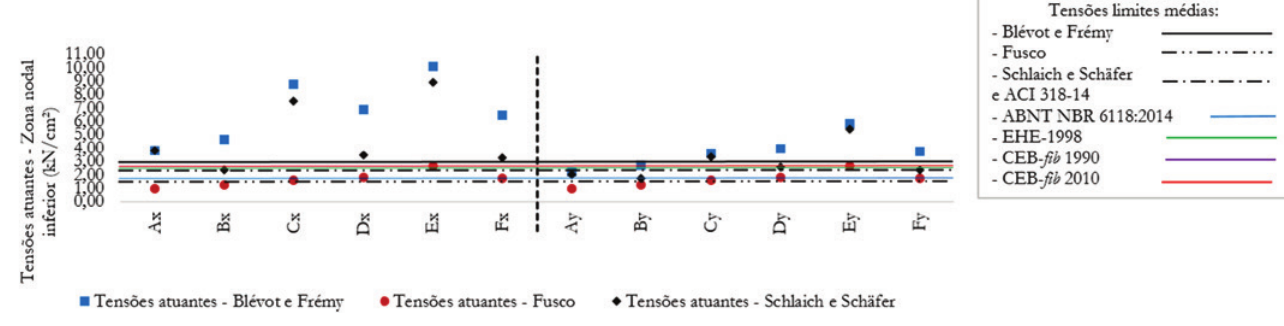
Modelos ensaiados por Adebar et al. [4] × σ